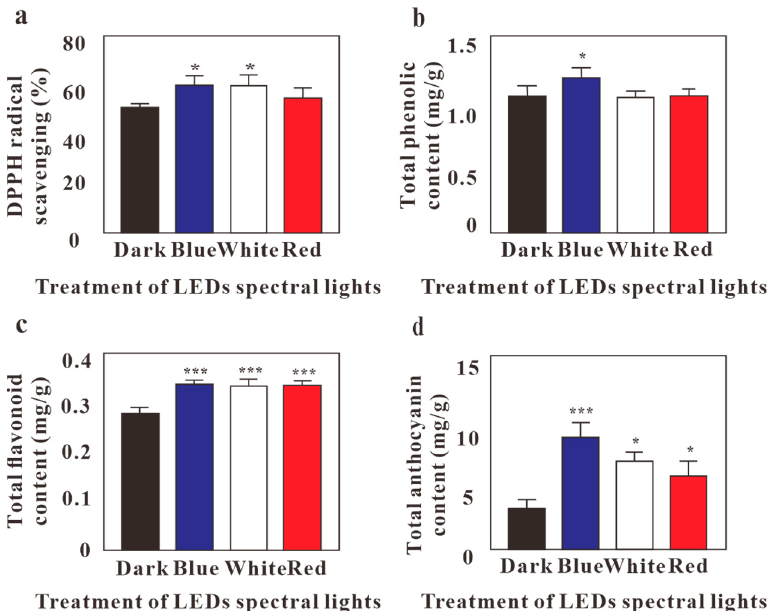
Figure 2. Effect of LEDs on callus culture for ( a ) DPPH free-radical savaging activity, ( b ) Total phenolic content, ( c )Total flavonoid content, and ( d ) Total anthocyanin content of G. procumbens in callus culture. Values are means ± standard deviation (SD) from three replicates ( n = 3). Ordinary one-way ANOVA followed by Dunnett’s multiple comparisons test were performed, where p < 0.05 and p < 0.001 are represented as * and ***, respectively.